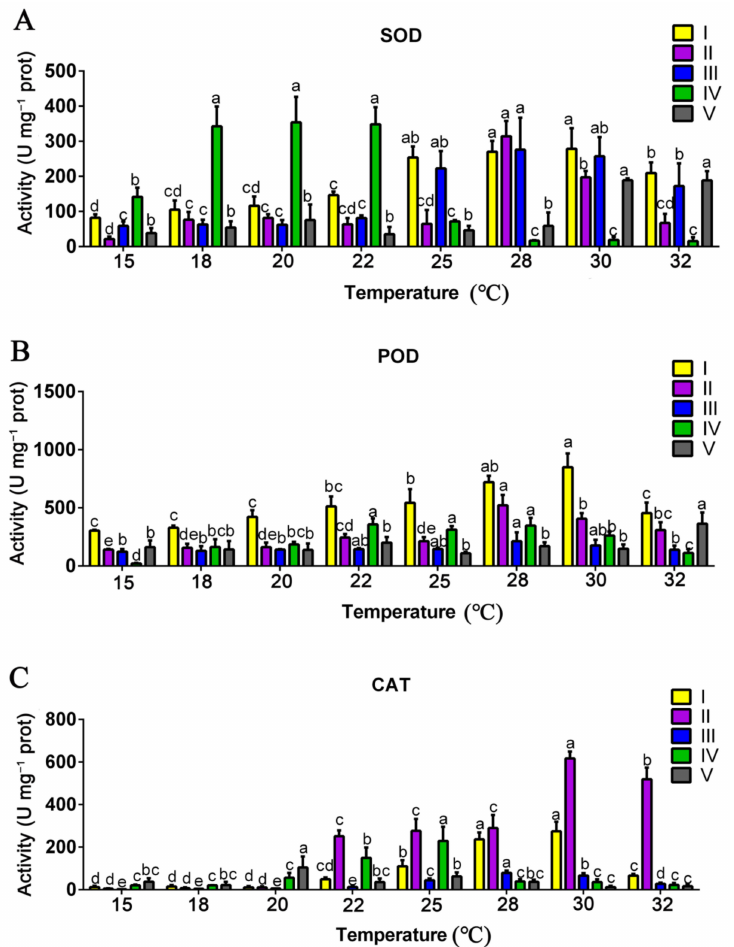
Figure 3. Effect of mycelial culture temperature on the activities of antioxidant enzymes. Activities of SOD ( A ), POD ( B ), and CAT ( C ) at different mycelial culture temperatures at different growth and developmental stages of P. ostreatus . CAT: catalase; SOD: superoxide dismutase; POD: guaiacol peroxidase. I, the stage of substrate half colonized by mycelia; II, the stage of substrate fully colonized by mycelia; III, the primordial stage; IV, the first harvest stage; V, the second harvest stage. The data are presented as the means from three independent measurements ± the standard deviations (indicated by the error bars). Different letters indicate significant differences between strains ( p < 0.05, as determined by Tukey’s